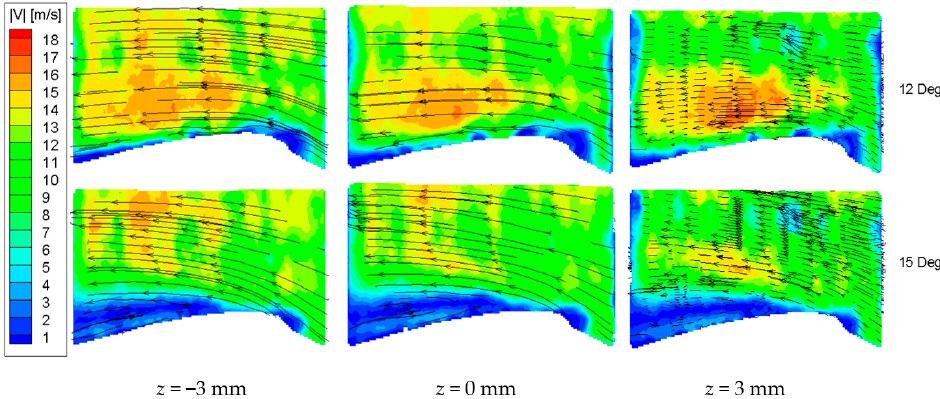
Figure 7. Three sample planes from two-camera 3D reconstruction for the smooth airfoil at two AoA.